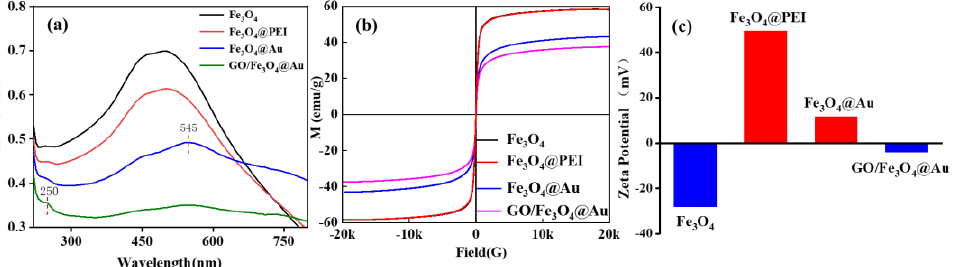
Figure 4. UV-vis spectra ( a ), hysteresis regression curves ( b ), and Zeta potential ( c ) of Fe 3 O 4